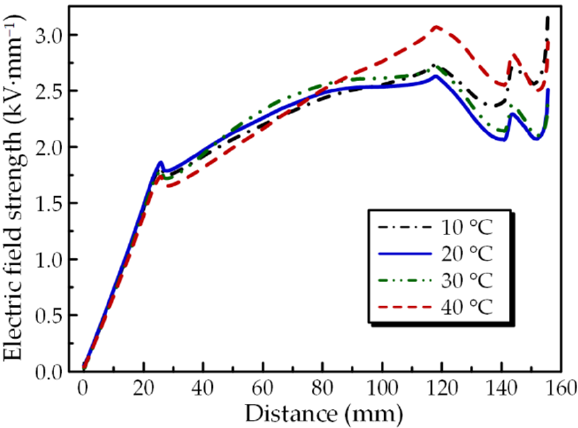
Figure 17. The influence of ambient temperature on the electric field distribution of the spacer. With an increase in the temperature from 10 ◦ C to 20 ◦ C, the field strength near the enclosure decreased. Further increases in the temperature led to an increase in the field strength. However, with an increase in ambient temperature, the overall temperature showed a linear increasing trend corresponding to the variation in the ambient temperature, as indicated in Figure 12. The electric conductivity of the spacer showed an exponentially increasing tendency with increasing temperature. Since the electric field distribution of the spacer is affected by the overall electric conductivity distribution of the spacer, this may lead to the non-monotonic variation in electric field strength distribution with increases in ambient temperature. Thus, an evaluation of the insulation properties referring to the weather and seasons should be considered for the long-term operation of DC-GIL.